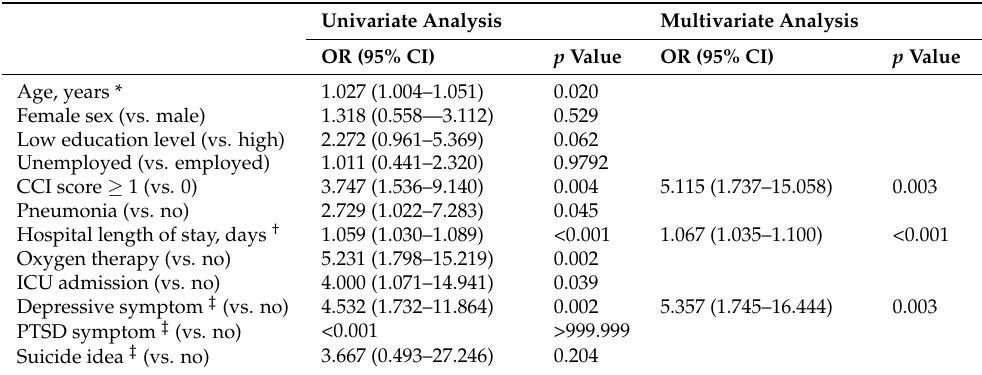
Table 4. Univariate and multivariate logistic analysis identifying predictors of new-onset (during hospitalization) mental disorders.